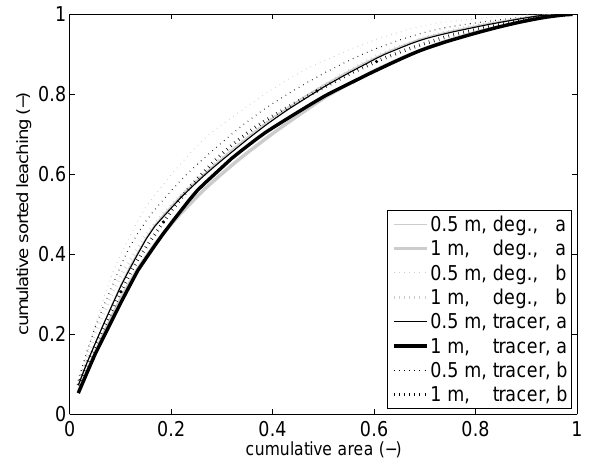
Fig. 13. Sorted and cumulated leached solute masses at 0.5 and 1 m depth, for a tracer and degradable solute (half-life time τ =10 d), in the legend a is used for 1997 with snowmelt, and b is used for 1997 without snowmelt.